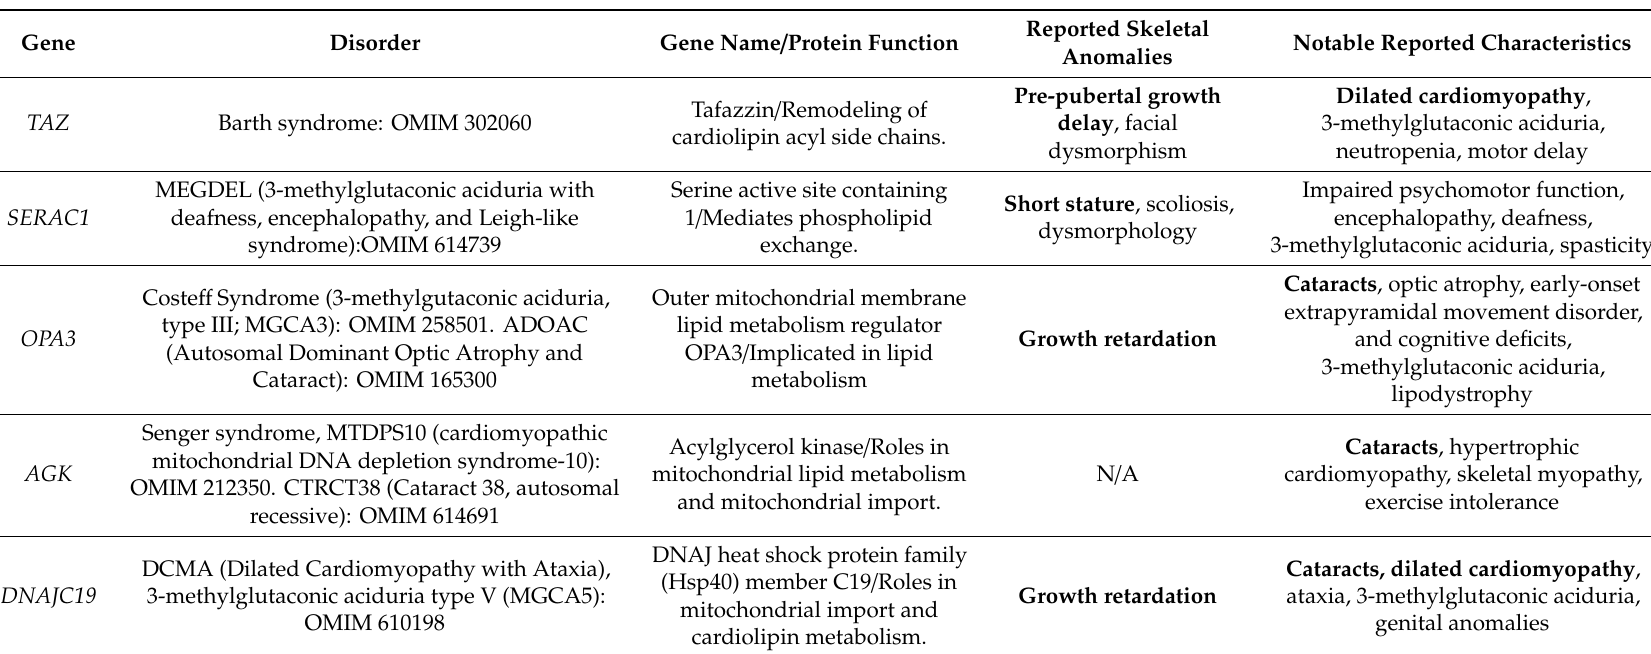
Table 4. Genes regulating mitochondrial lipid homeostasis implicated in mitochondrial disease, indicating formal OMIM (Online Mendelian Inheritance in Man) disease designations, gene names, protein functions, and phenotypic descriptions. Disease phenotypes indicted in bold are also common in mitochondrial skeletal